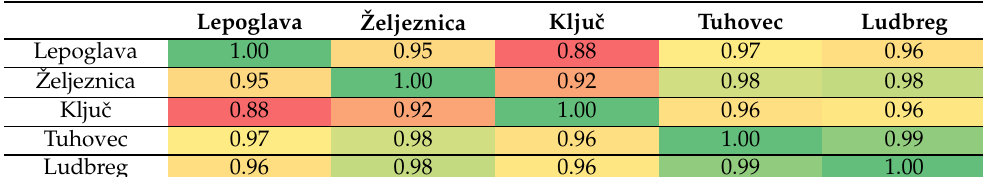
Table 6. Cross-correlation peaks matrix for the measurement stations. The red to green color bar indicates values between 0.88 and 1.